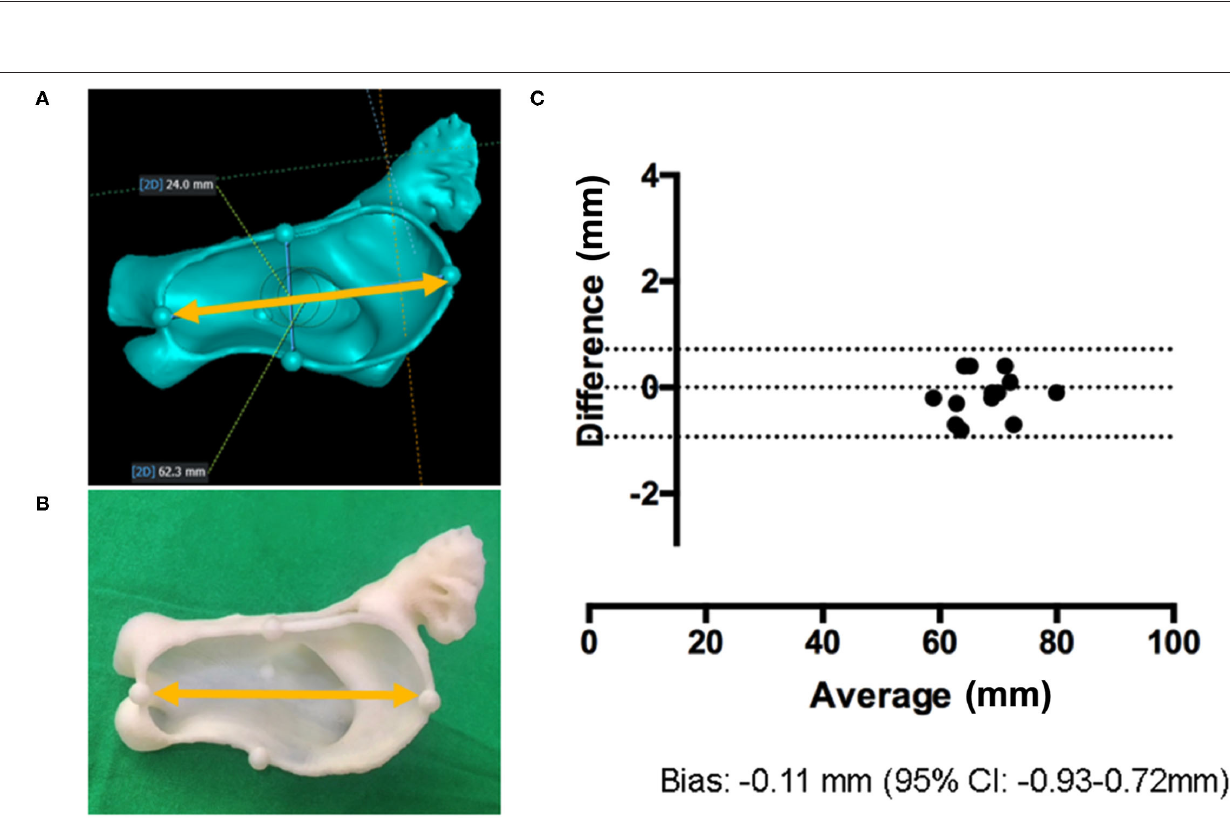
( Figure 4B ), showing an underestimation of the LAAO device